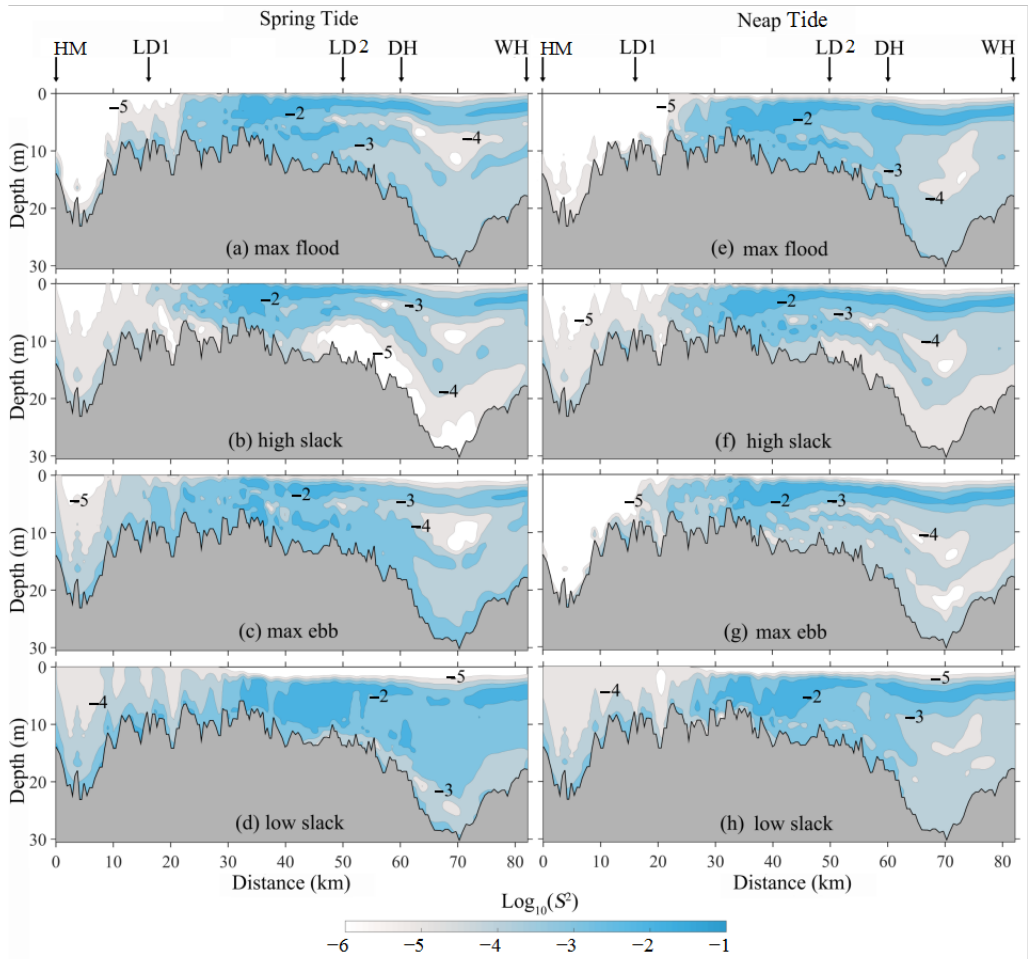
Figure 10. Longitudinal distributions of the square of the shear log 10 ( S 2 ) along the channel (from stations HM to WH) at the West Channel in the Pearl River Estuary on a spring tide (left panels) and a neap tide (right panels) in the wet season.